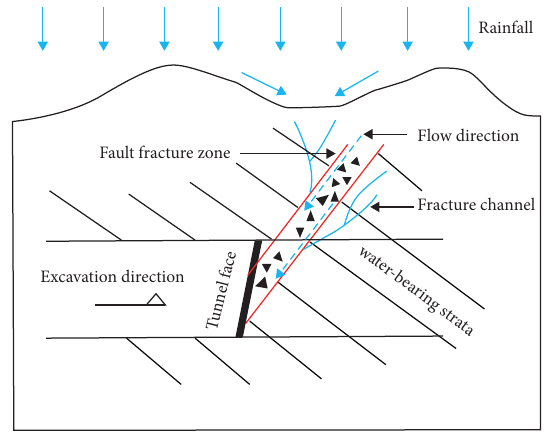
Figure 4: Diagram of water inrush in a fault fracture zone.